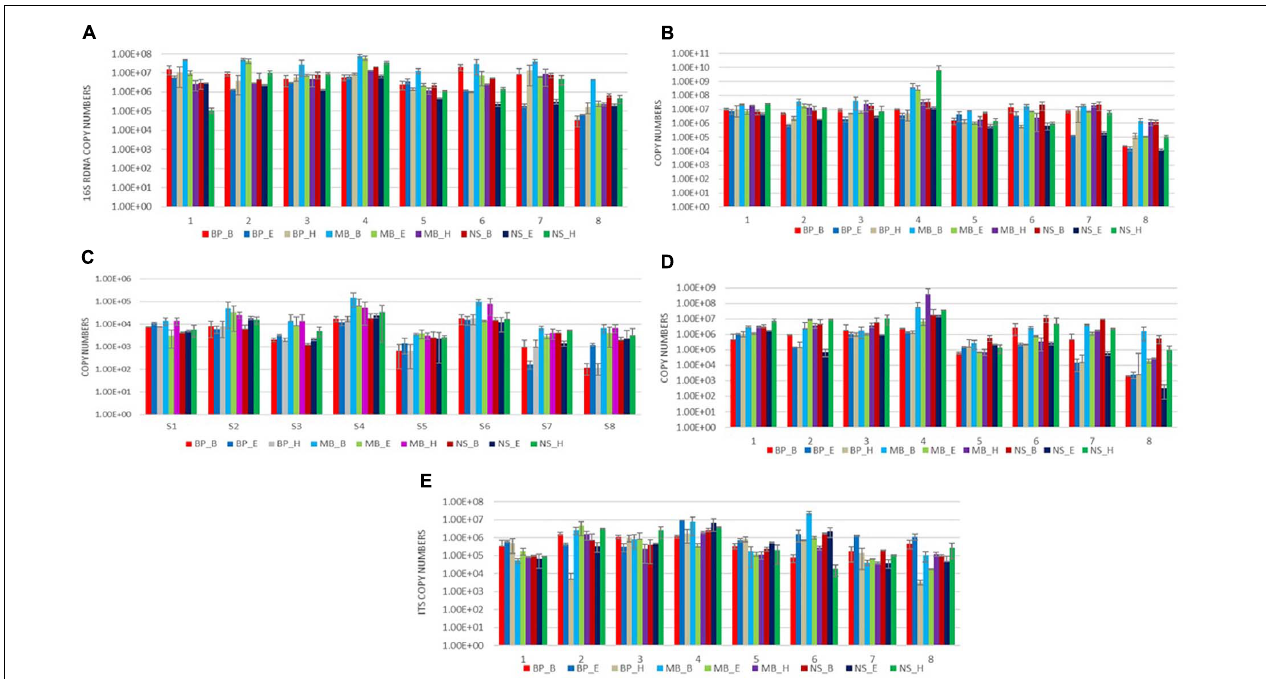
FIGURE 3 | Results of amplification by qPCR of DNA extracted from eight sausages using nine DNA isolation protocols, using five specific primers targeting the following: (A) the 16S rRNA gene of total bacteria; (B) the 16S rRNA gene of Lactobacillus ; (C) the 16S rRNA gene of Enterococcus ; (D) the 16S rRNA gene of Bacillus ; and (E) the ITS region of fungus. Each of the nine DNA extraction protocols is indicated by a unique color; abbreviations for the samples and the protocols are given in Tables 1 , 2 , respectively.